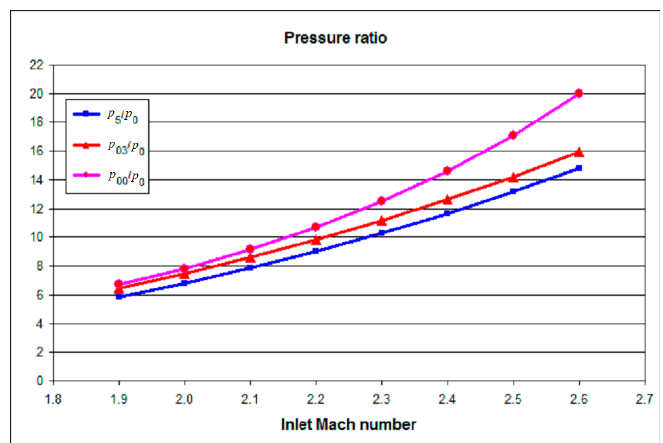
Figure 7. Local values of stagnation pressure to static inlet pressure after isentropic compression ( p 00 / p 0 ), after the shockwave system ( p 03 / p 0 ), and the ratio of the static pressure at the combustion chamber inlet to inlet pressure ( p 5 / p 0 ).